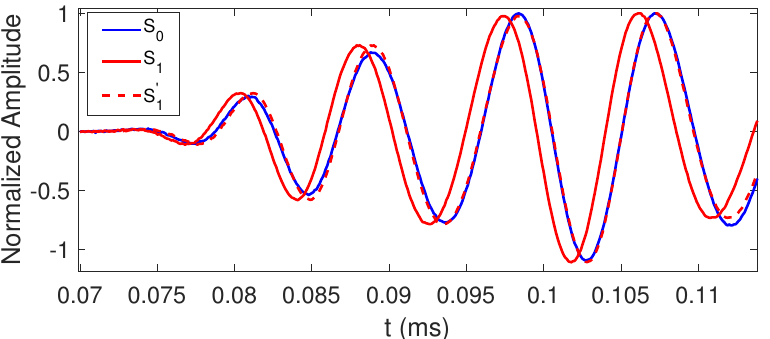
Figure 1. Stretching technique on two ultrasonic signals acquired from a stress-free state S 0 , and a stressed state S 1 . The red dash line is the stretched and interpolated signal S (cid:48) parameter ε max